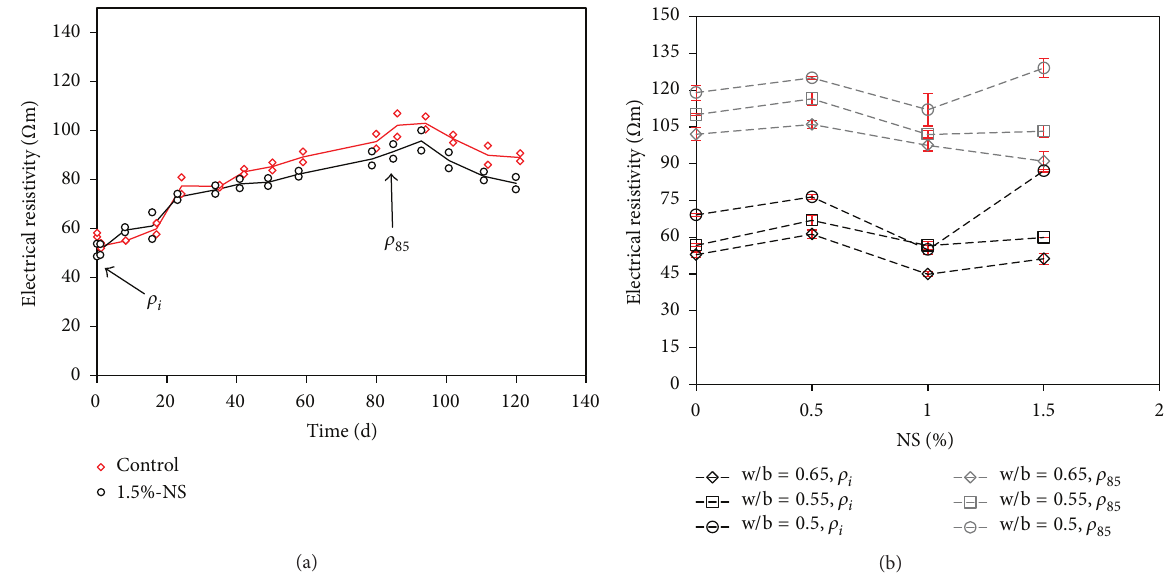
Figure 7: (a) Electrical resistivity of concrete with w / b = 0.65 immersed in water after curing for 28 days for control and 1.5% NS addition. The solid lines express average values of the two data points. Initial resistivity, 𝜌 𝑖 , and resistivity of 85-day immersion, 𝜌 85 , are also shown and (b) their average values with their variations as a function of NS content.